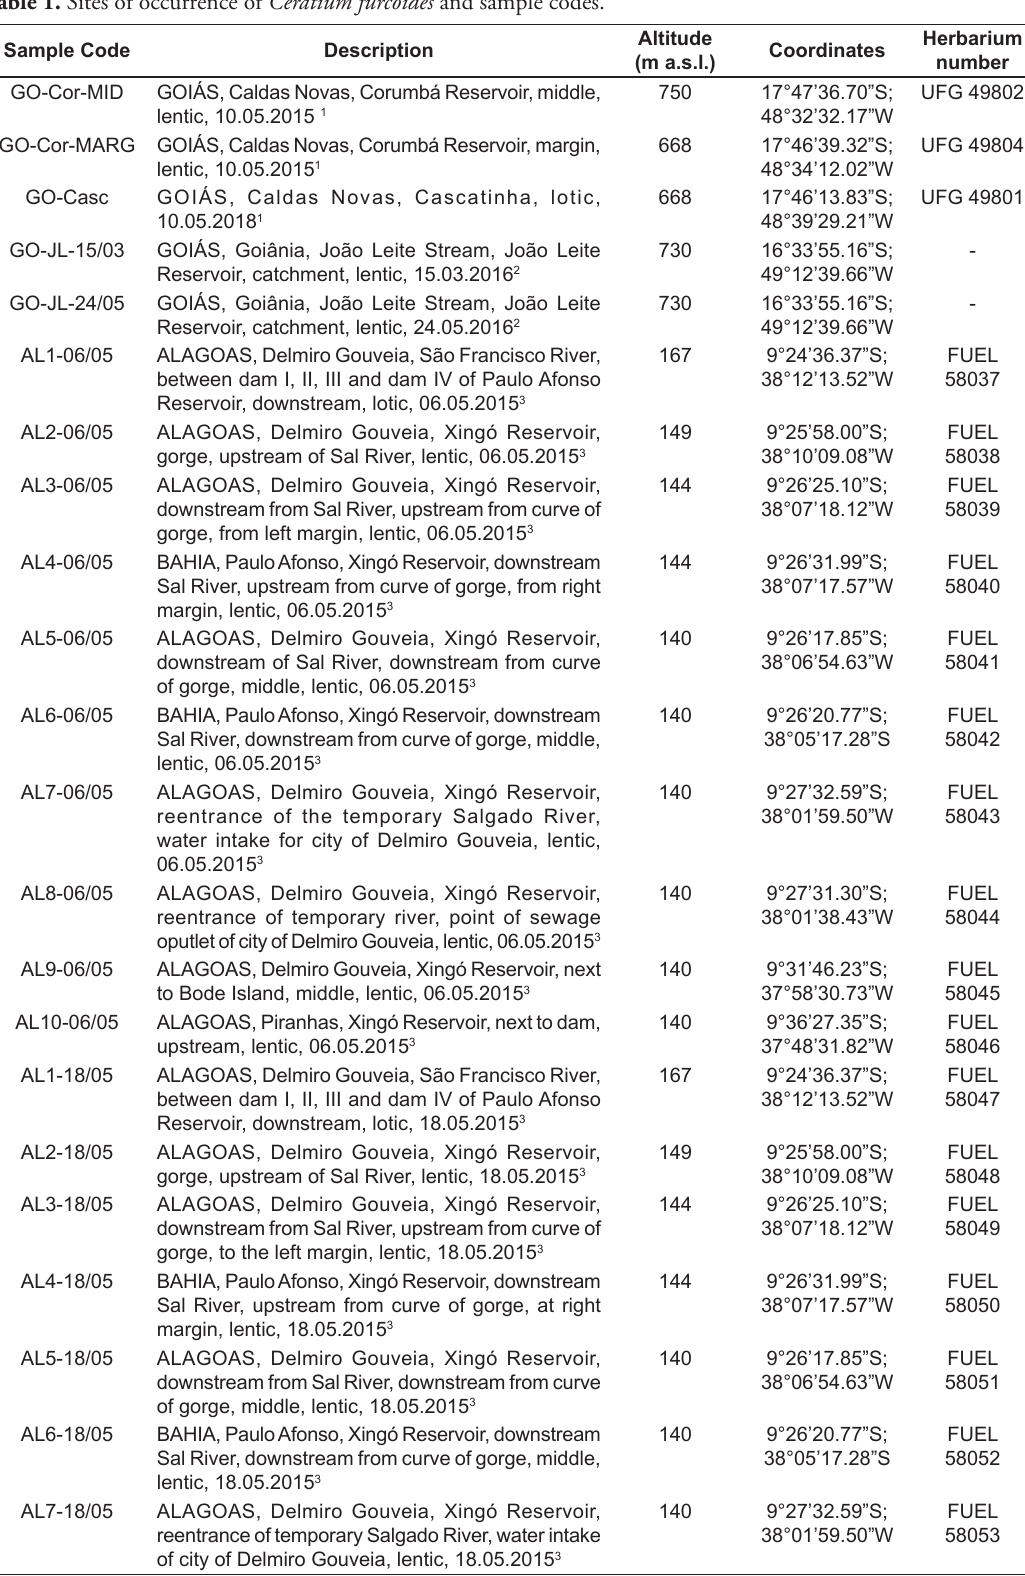
Table 1. Sites of occurrence of Ceratium furcoides and sample